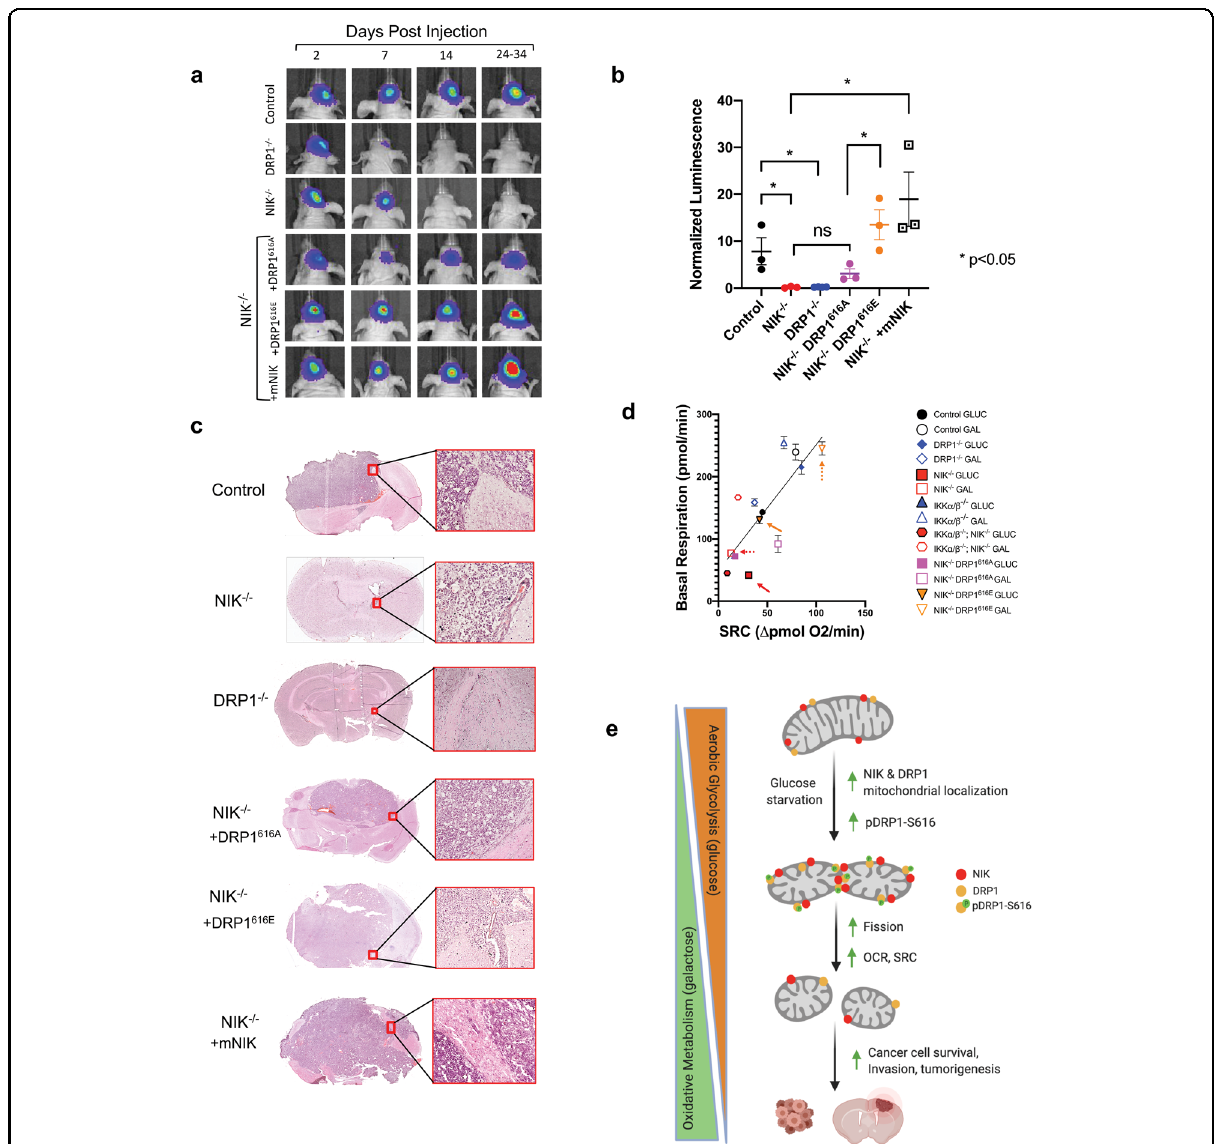
Fig. 8 Constitutively active DRP1 rescues oxidative metabolism and tumorigenic potential in NIK − / − GBM cells. a Representative cropped images from IVIS imaging showing luminescence of individual mice pictured here over the course of 35 days, n ≥ 3 mice per cell type. Mice were imaged at regular intervals with the exception of the fi nal endpoint since mice with large tumor growth required euthanasia at earlier timepoints. Mice harboring DRP1 − / − , NIK − / − , and NIK − / − + DRP1 616A tumors were last imaged at day 35 and mice harboring NIK − / − + DRP1 616E and NIK − / − + DRP1 616E + mNIK tumors were last imaged at days 28 and 24, respectively. b Graph depicting fold change luminescence on day 28 from fold change on day 7, with the exception of NIK − / − + mNIK which is fold change from day 21. c Representative images of tumors and histology (pictured as enlargements of red box inset) in control, NIK − / − , DRP1 − / − , NIK − / − DRP1 616A , NIK − / − DRP1 616E , and NIK − / − + mNIK. d Composite graph plotting basal respiration vs mean spare respiratory capacity (SRC) ( n ≥ 3 replicates per each cell type). Solid arrows indicate glucose condition and dotted arrows indicate galactose condition for NIK − / − and NIK − / − DRP1 616E cell lines (red and orange, respectively). e Model: NIK and DRP1 mitochondrial localization increase upon glucose starvation and switch to galactose media resulting in transition from aerobic glycolysis to reliance on oxidative metabolism. NIK regulates DRP1 phosphorylation (pDRP1-S616), increases mitochondrial fi ssion, OXPHOS, and spare respiratory capacity (SRC), leading to increased cancer cell survival, invasion, and tumorigenic